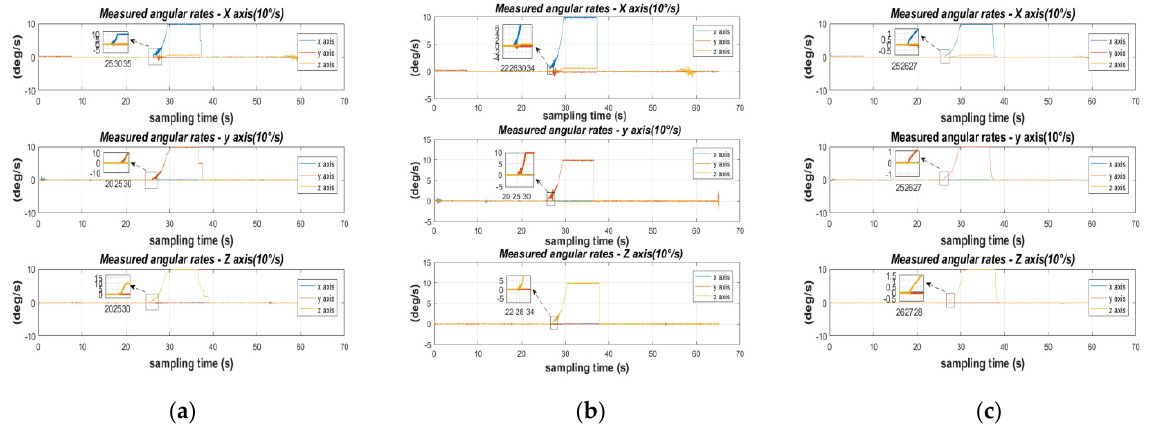
Figure 10. MEMS0 gyroscope in dynamic conditions: ( a ) raw sensor; ( b ) LM calibrated sensor; ( c ) fused calibrated sensing. Table 10. Comparison of MEMS0 gyroscope parameters under dynamic conditions.